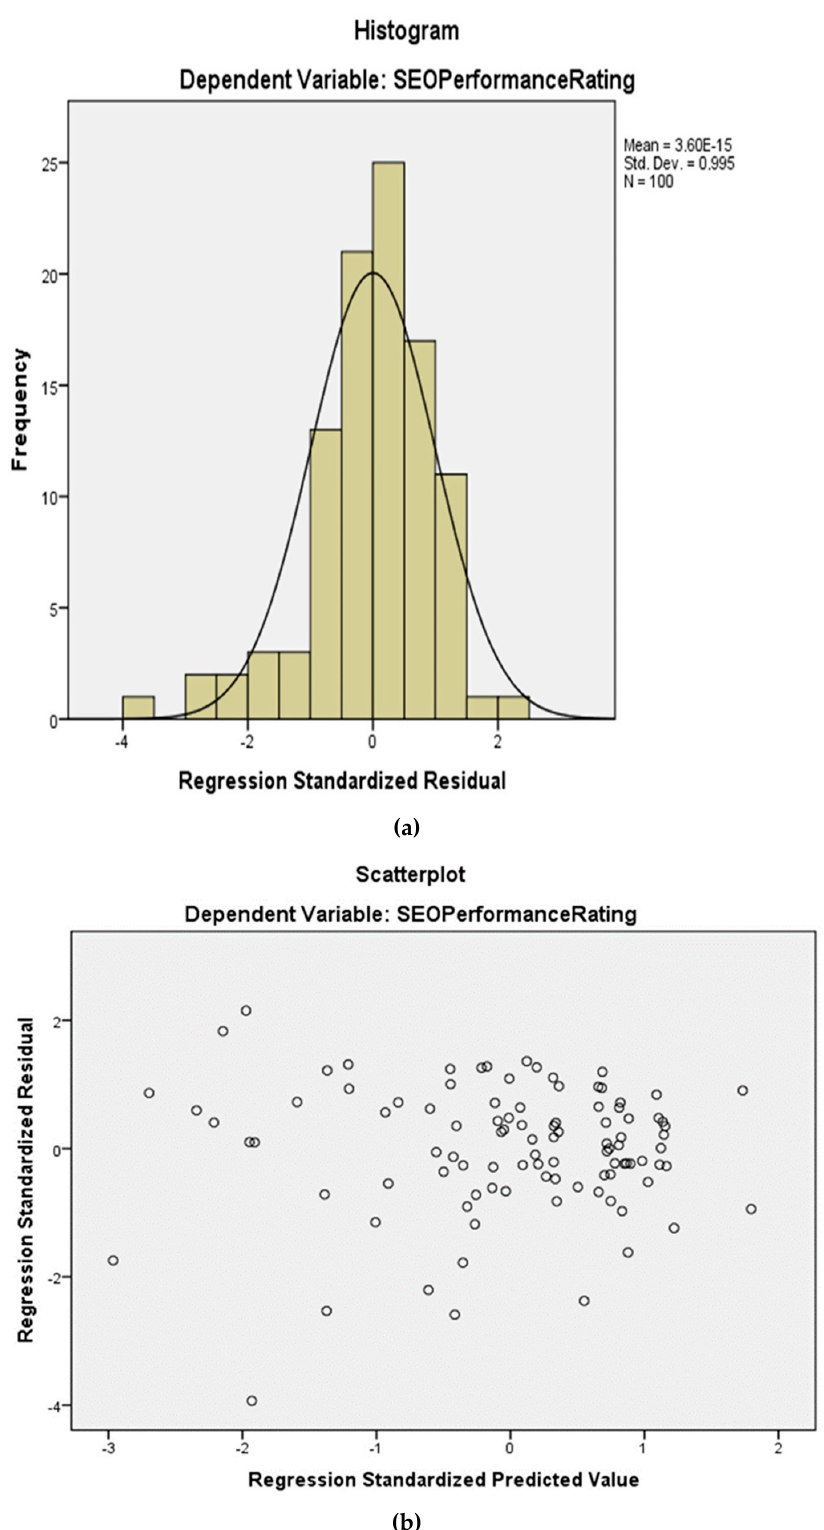
Figure 2. ( a ) The histogram of the standardized residuals shows a normal distribution. ( b ) The scatterplot shows that this is an acceptable predictive model (the prediction is on the x-axis, and the accuracy is on the y-axis - Residual = Observed – Predicted).